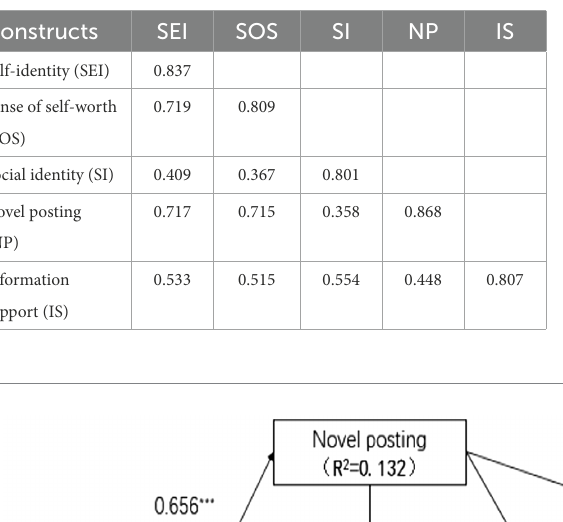
TABLE 4 Correlations among latent constructs.